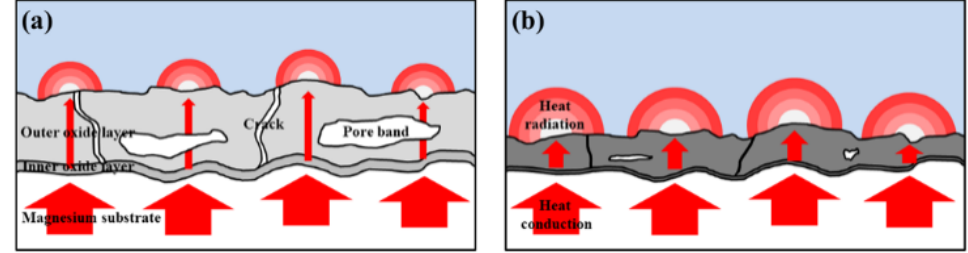
Figure 13. Schematic diagram of the heat-transfer mechanism of the PEO coatings with and without CNT additive: ( a ) the PEO coating without CNT additive and ( b ) the PEO coatings with CNT additive.